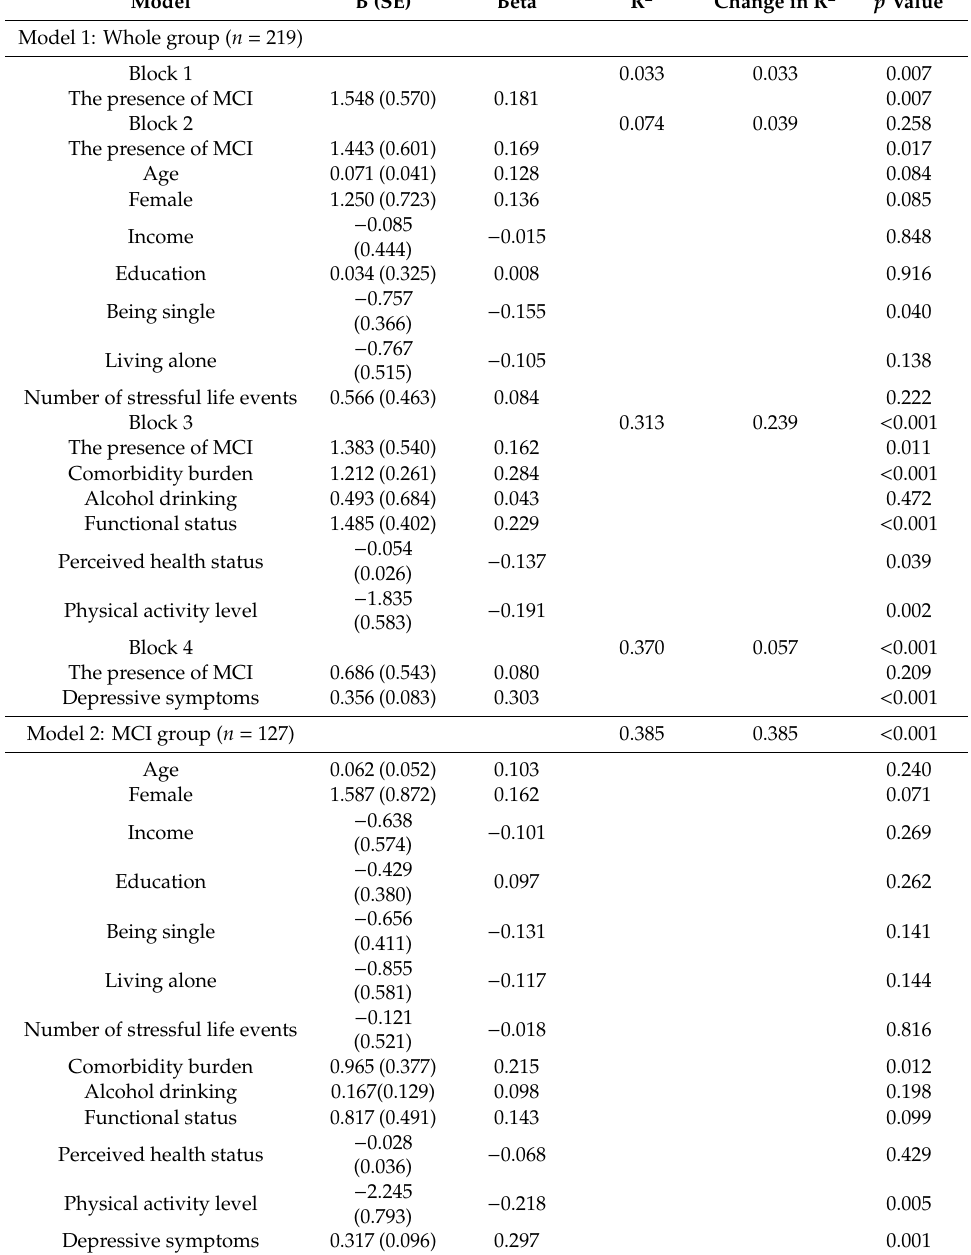
Table 3. Multivariate correlates of sleep disturbance ( n =